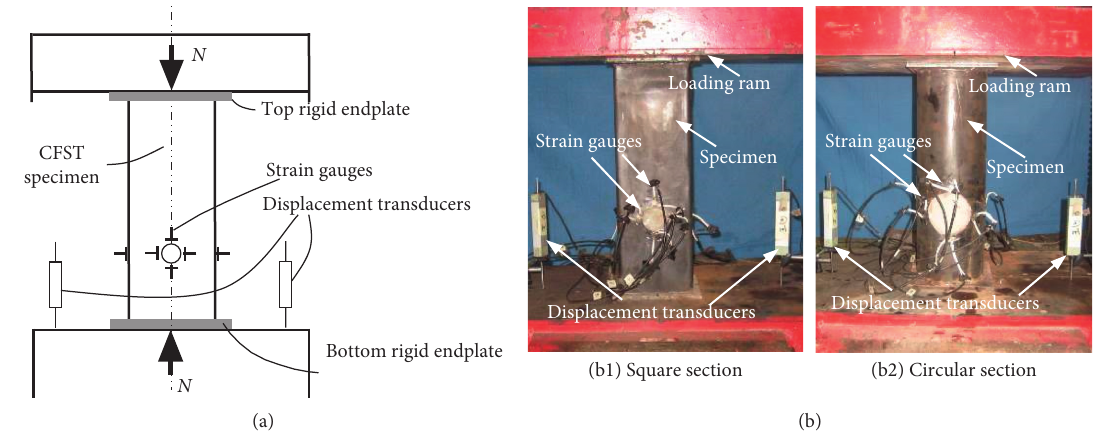
Figure 2: Test setup for opening CFST columns. (a) Schematic view. (b) Photo during test.